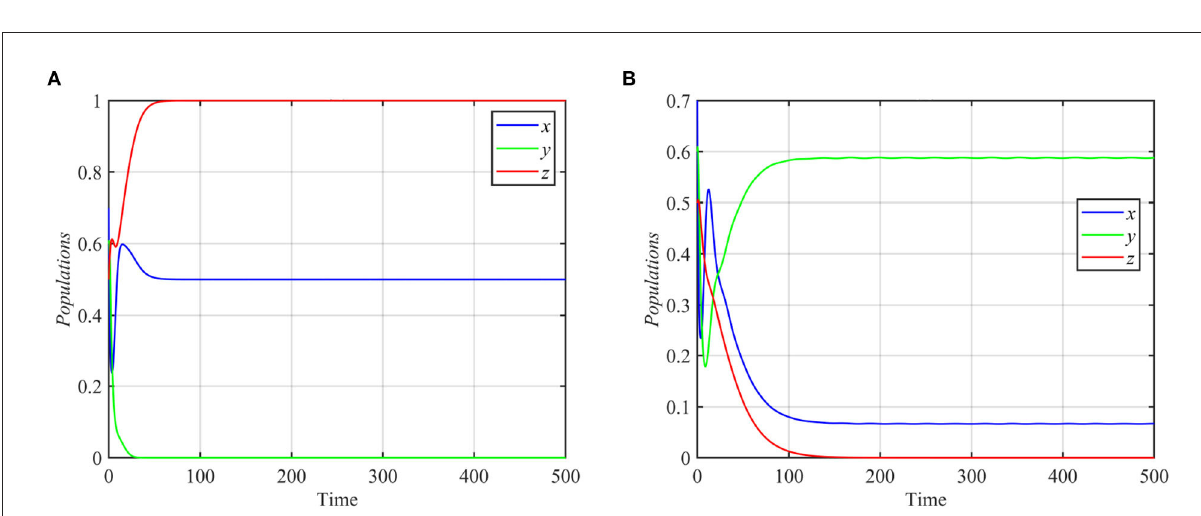
FIGURE5 Trajectories of system (1) for different values of e 2 and e 3 , with other parameters as in equation (17). (A) Time series for trajectories of x , y , and z for e 2 0.4, which approach E 2 (0.5,0,1). (B) Time series for trajectories of x , y , and z for e 3 = =